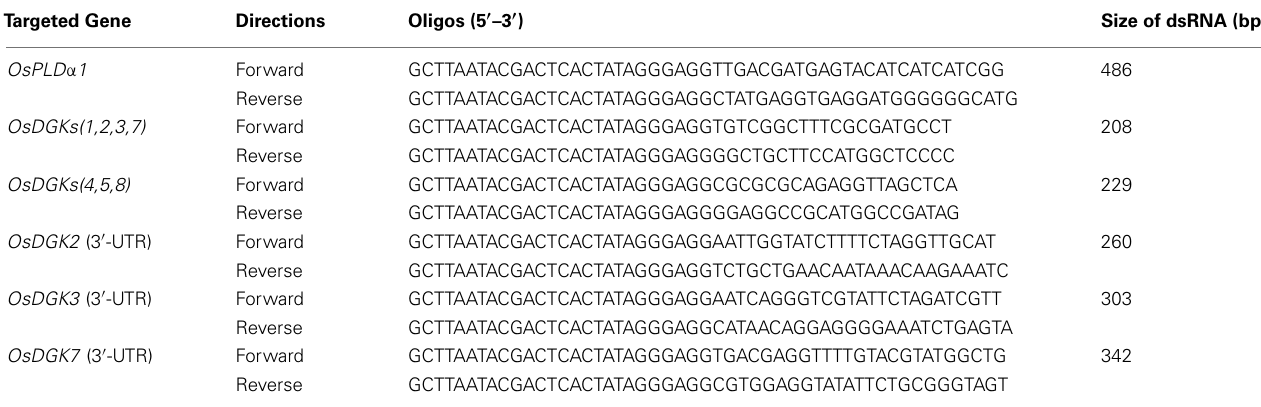
TableA4 | List of oligos used in amplifying DNA templates for in vitro dsRNA synthesis. Targeted Gene